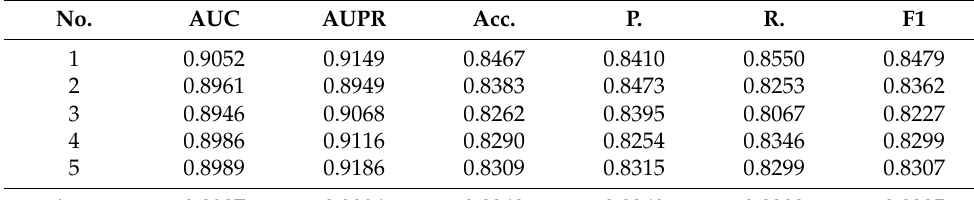
Table 1. Prediction results of LRGCPND in five-fold CV.